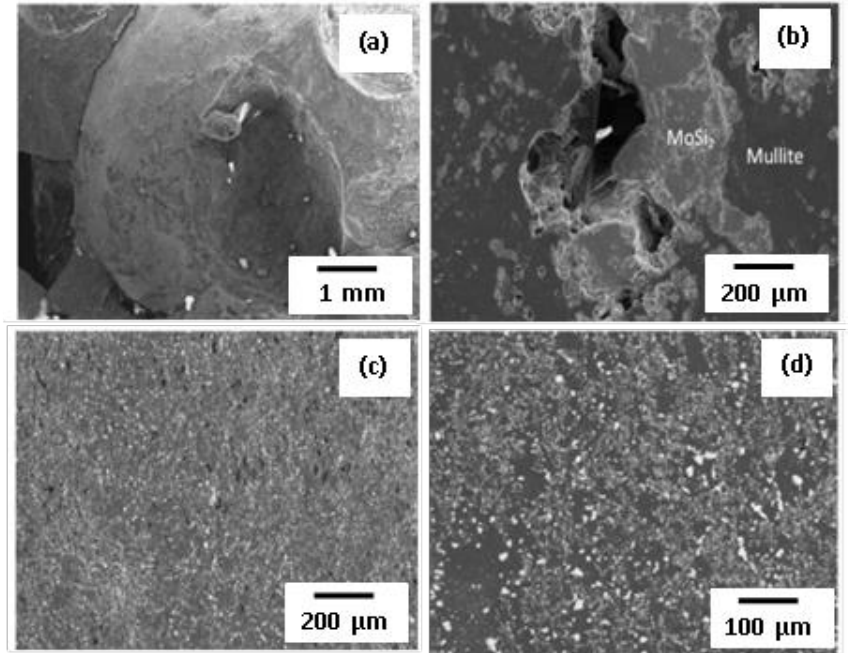
Figure 9. SEM micrographs of mullite-MoSi 2 composite: ( a ) without dilution; ( b ) diluted by 20 vol.%; ( c ) diluted by 25 vol.% and pressed at 82 MPa; ( d ) pressed at 234 MPa. Reprinted with permission from Zaki et al. (2014). Copyright 2014 International Journal of Refractory Metals and Hard Materials [68].